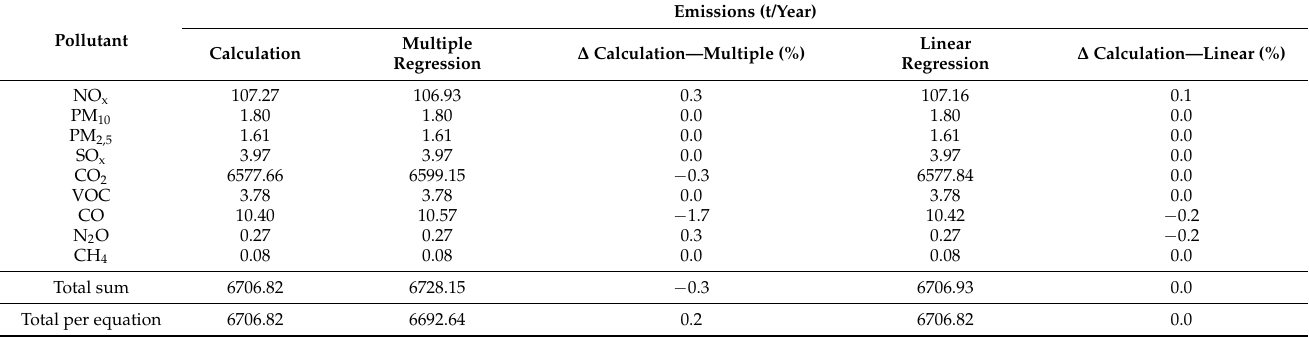
Table 20. Emissions estimation results comparison by pollutant for the 16 ships applying regression equations (Table